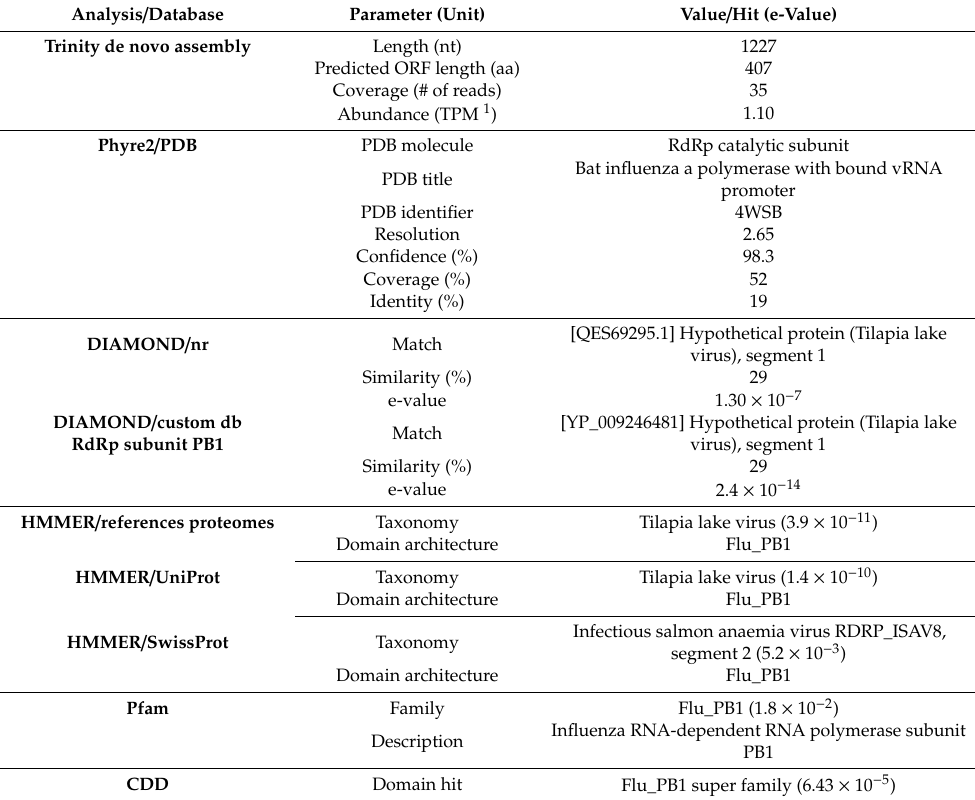
Table 1. Summary of analyses and parameters used for the detection of Lauta virus